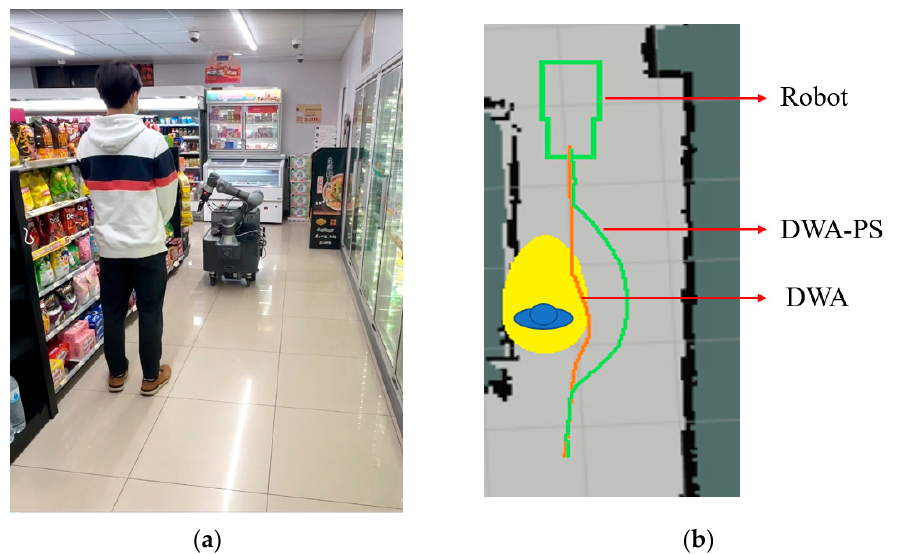
Figure 13. ( a ) The robot faced an incoming customer and ( b ) the resultant paths by applying the DWA and DWA-PS.